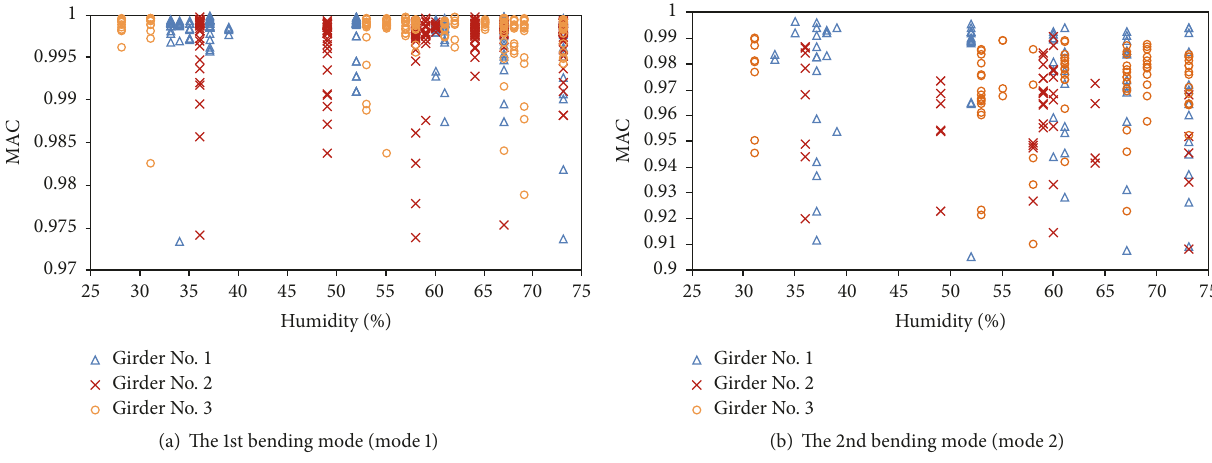
Figure 20: ((a)-(b)) Identified MAC values of two bending modes versus measured humidity.